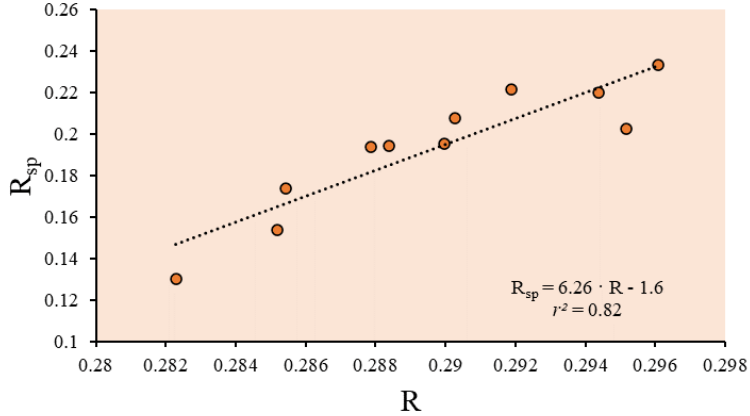
Figure 6. Linear relationship between N stress indices measured by smartphone (R sp ) and multi-spectral image station (R) in